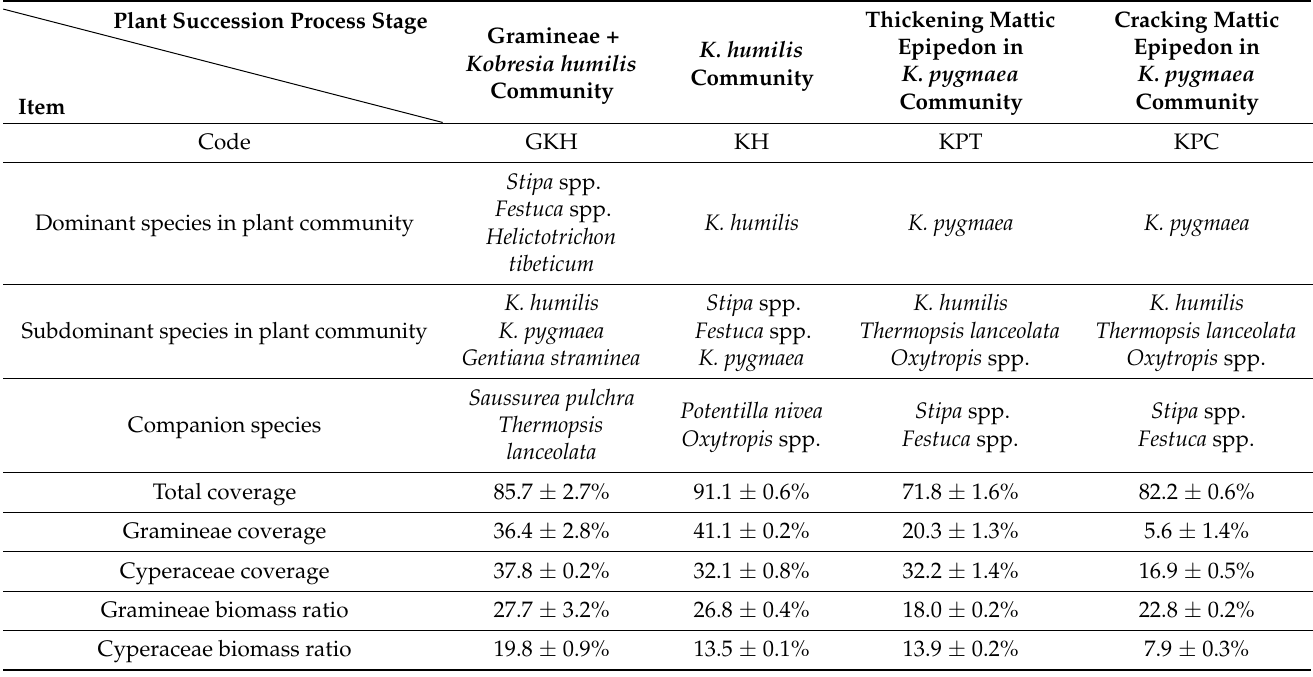
Table 2. Characteristics of aboveground plant community.